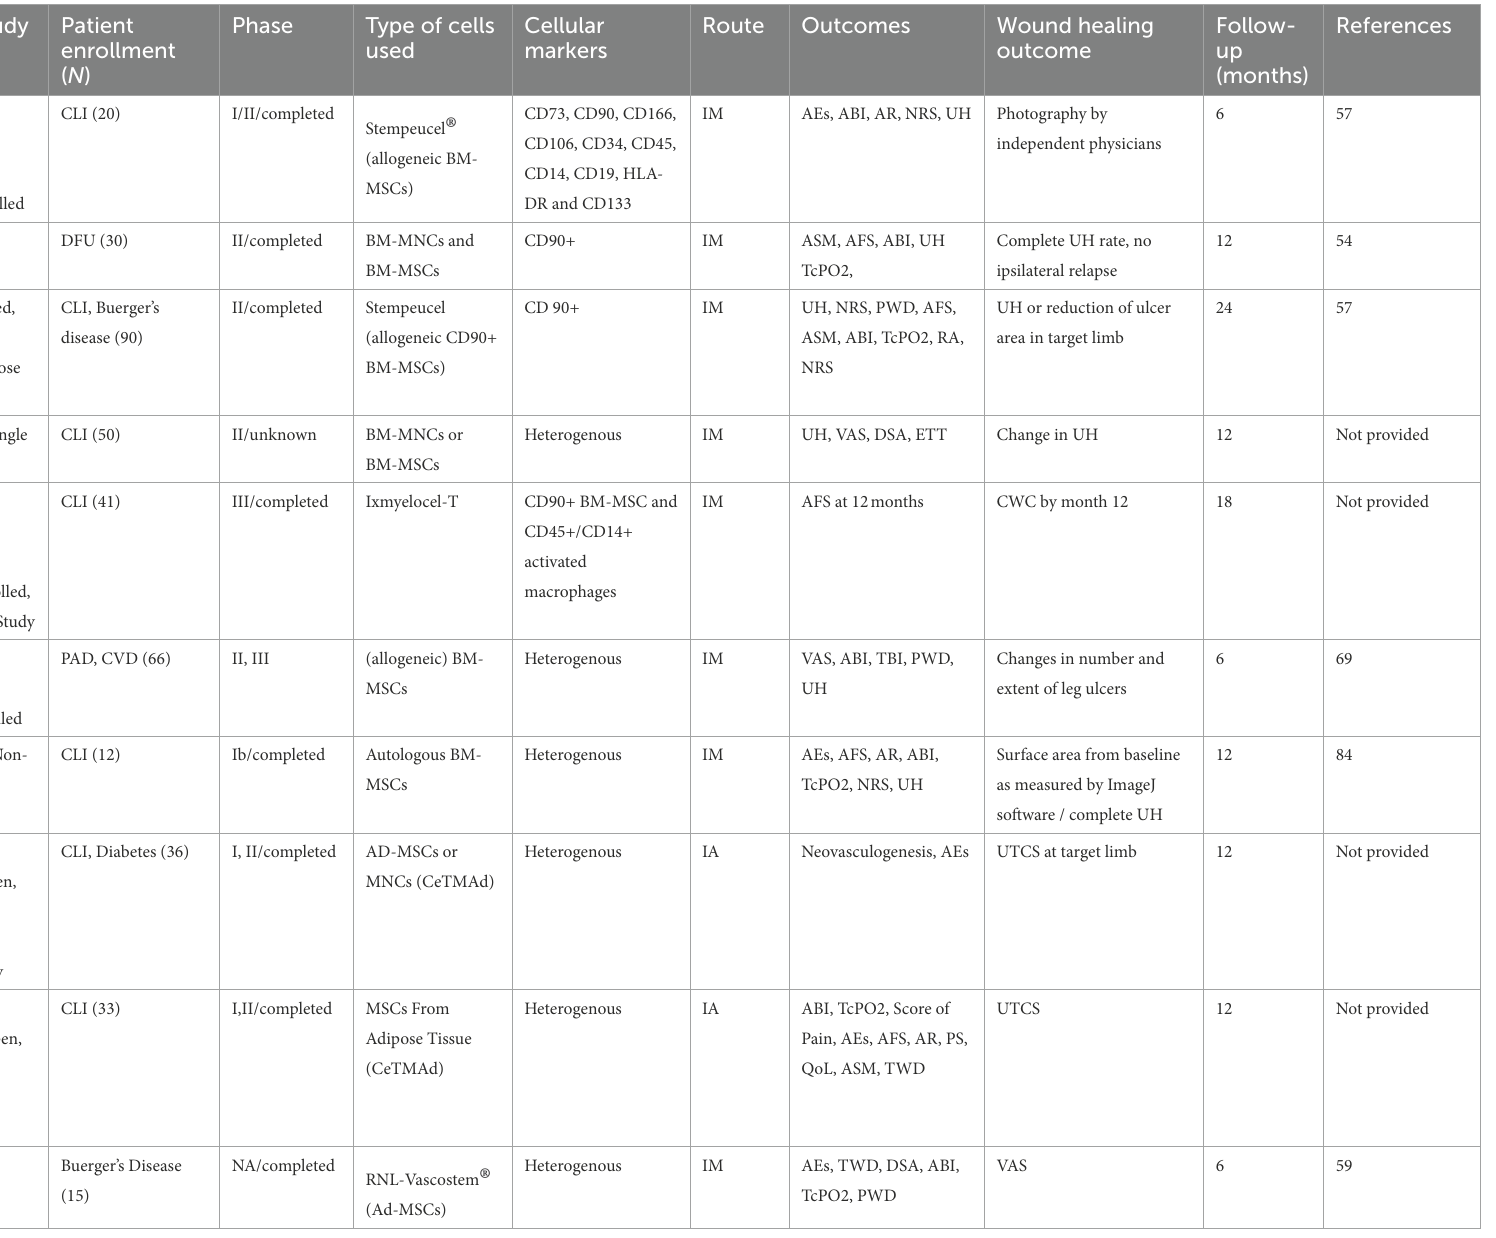
TABLE 1 Clinical trials utilizing cell-based therapy for patients with chronic limb-threatening ischemia (CLTI). Trial